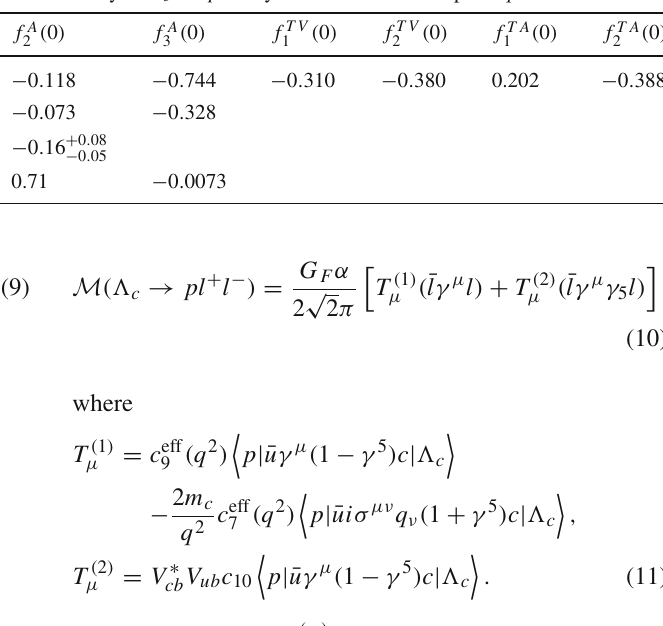
Fig. 1 Form factors of the rare (cid:2) c → p transition Table 2 Comparison of theoretical predictions for the form factors of weak baryon (cid:2) c → p decays at maximum recoil point q 2 =